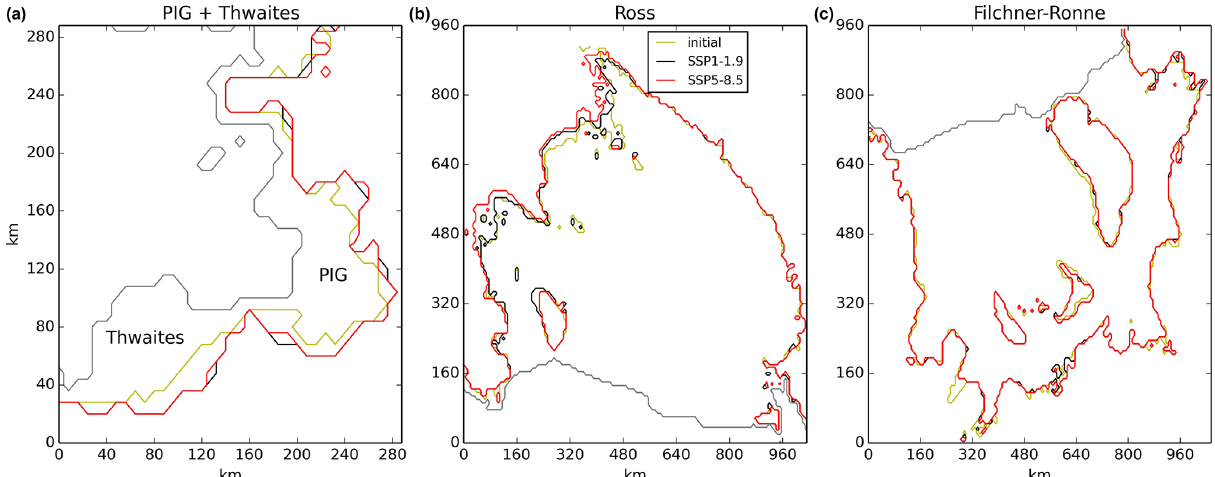
Figure 17. Grounding-line change in the (a) Pine Island and Thwaites glaciers and (b) Ross and (c) Filchner–Ronne ice shelves. Grey: ice front, yellow: initial grounding line, black: grounding line for SSP1–1.9 in 2100, red: grounding line for SSP5–8.5 in 2100.